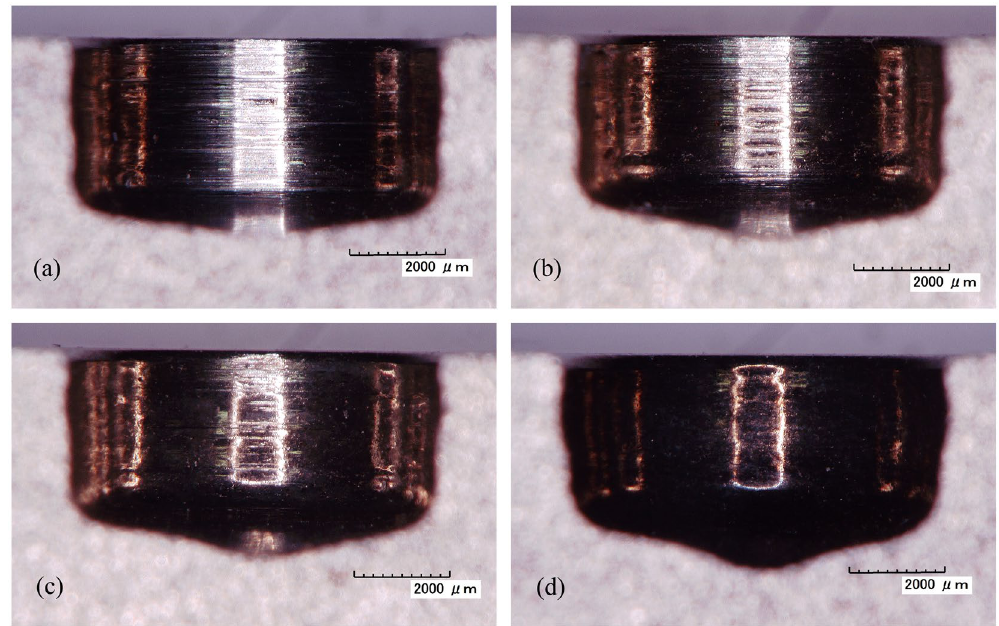
Figure 10. Cross-sections of machined slots at different applied voltages: ( a ) 10 V, 1.0 mm min − 1 ; ( b ) 15 V, 1.3 mm min − 1 ; ( c ) 20 V, 1.5 mm min − 1 ; ( d ) 25 V, 1.6 mm min − 1